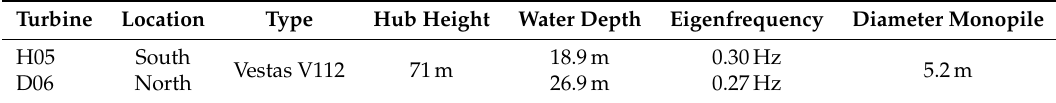
Table 1. Main properties of the considered turbines (eigenfrequencies according to Weijtjens et al. [30]).